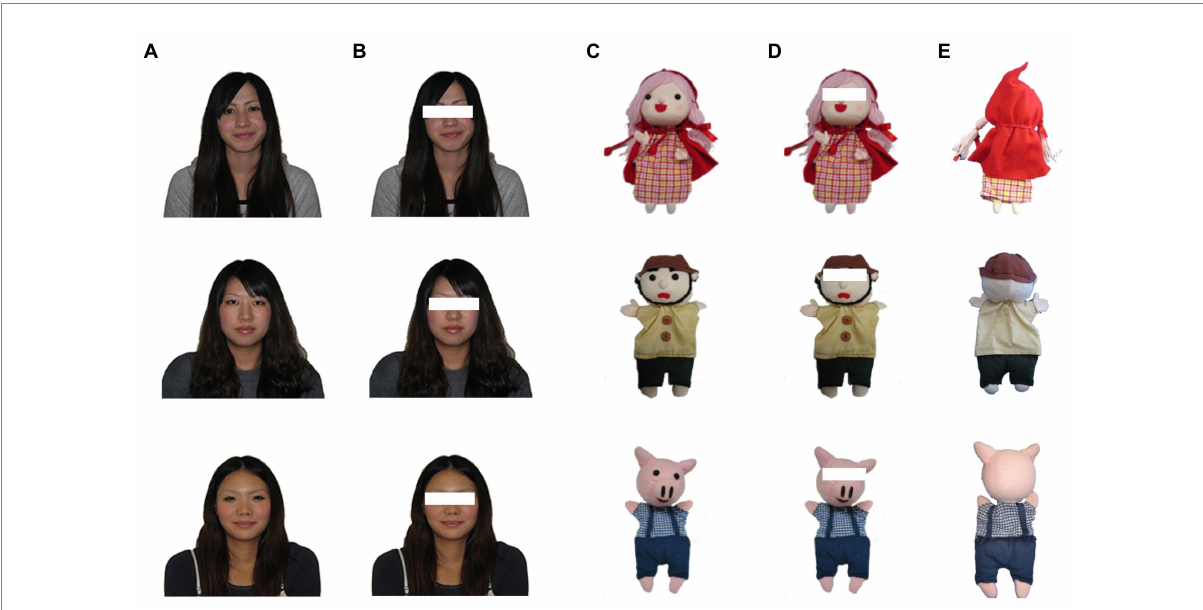
FIGURE 1 Examples of stimuli used in this study. The upper doll is a little girl with a red hood, and the middle doll is a hunter from “Little Red Riding Hood.” The lower doll is a pig from “The Three Little Pigs.” We used the following types of stimuli; (A) a maker with no mask, (B) a maker having the eye regions masked, (C) a doll with no mask, (D) a doll having the eye regions masked, and (E) back view of the doll. In Experiment 1, we used stimuli (B,D) .